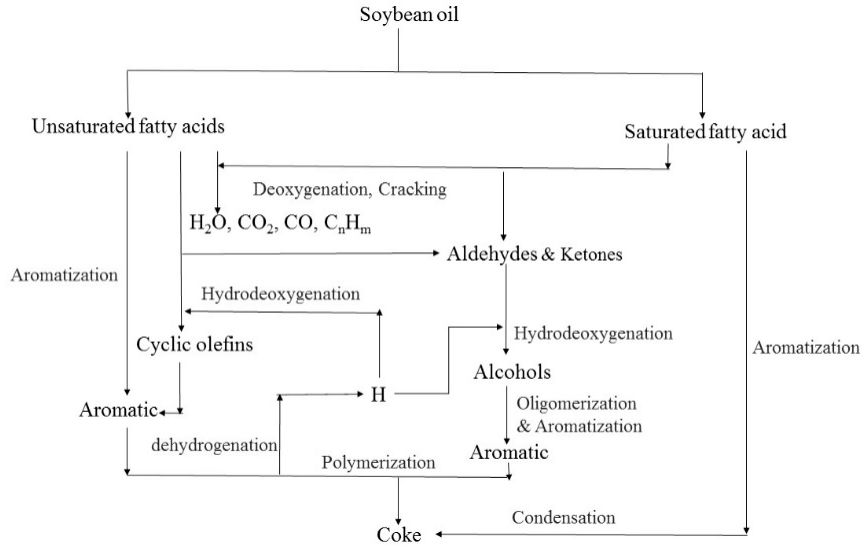
Figure 6. Main reaction pathway for the FCC of waste cooking oil over a LDO-75